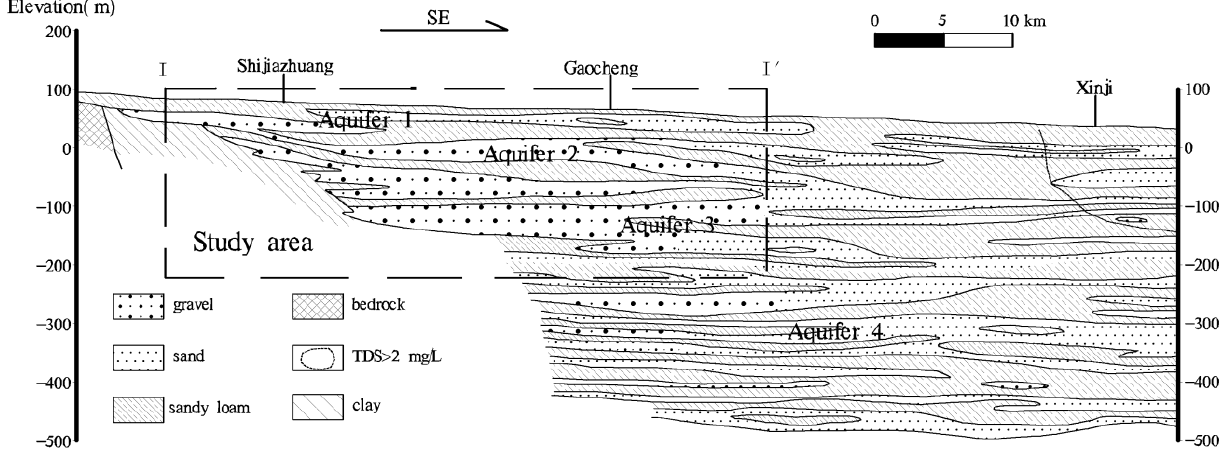
Figure 2. The hydrogeologic cross section in Shijiazhuang. The range of study area is marked by rectangle with dashed lines. The Quaternary aquifers are divided into four groups named as Aquifers